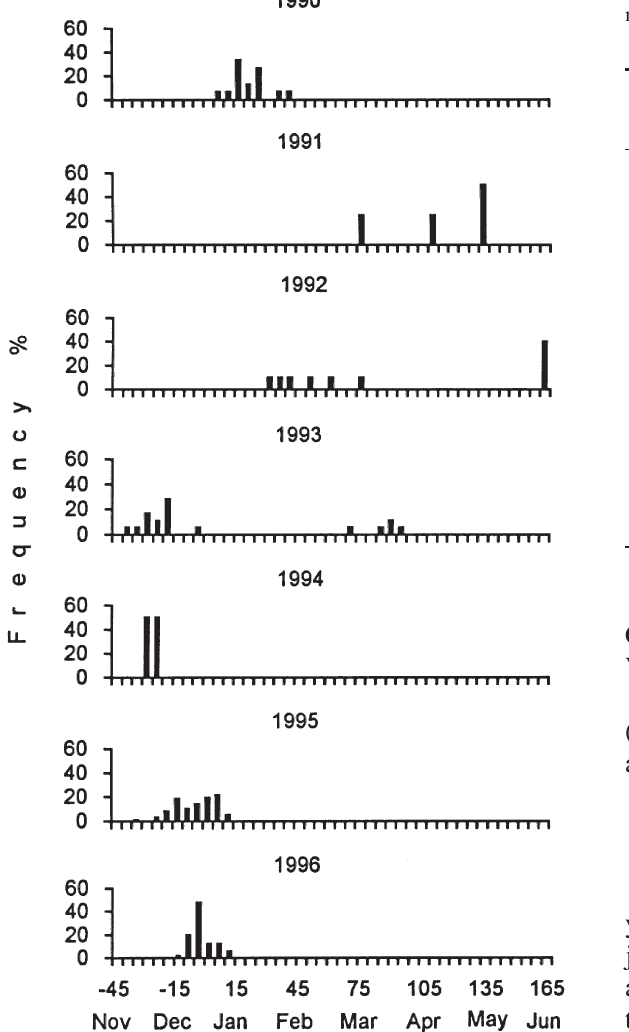
F IG . 5. – Back-calculated hatch time of juvenile Pacific mackerel, Scomber japonicus , from the Gulf of California.